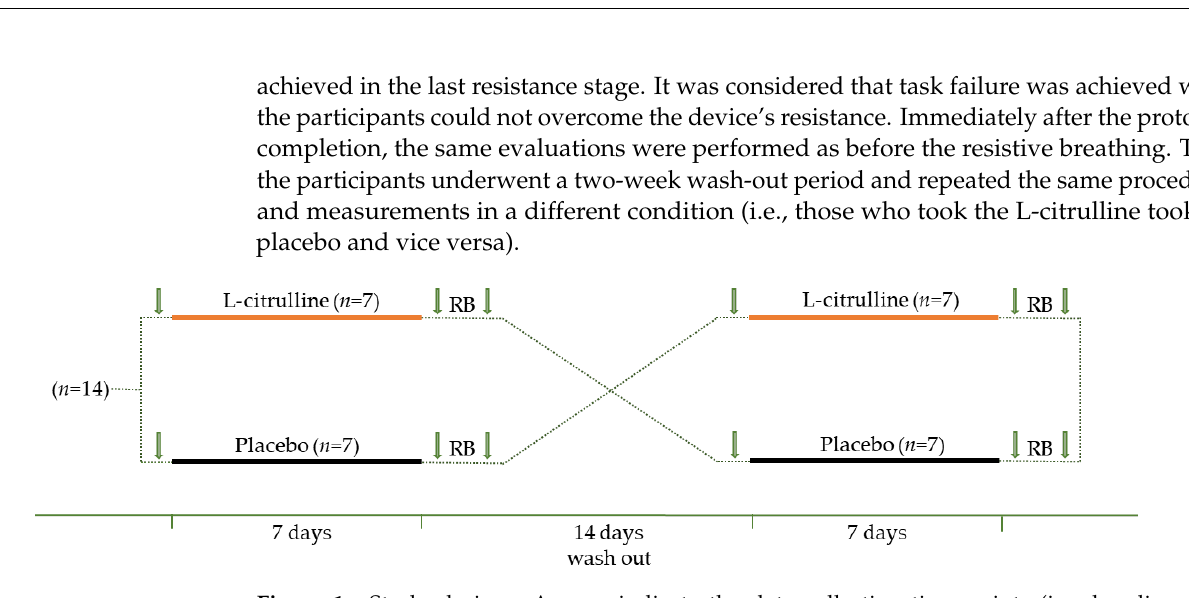
Figure 1. Study design. Arrows indicate the data collection time points (i.e., baseline, post-supplementation, and post-resistive breathing to task failure). RB, resistive breathing.